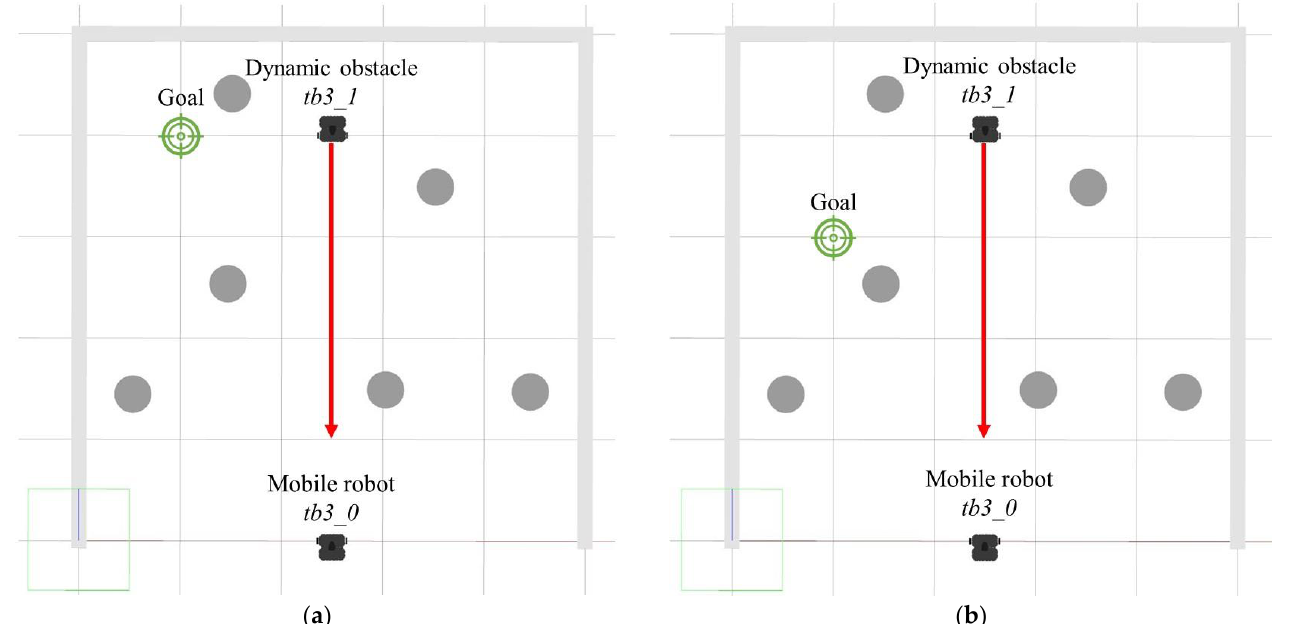
Figure 13. ( a ) Gazebo simulation for dynamic environment scenario 1 with goal point of (1.0,4.0) for 𝑡𝑏3_0 , ( b ) Gazebo simulation for dynamic environment scenario 1 with goal point of (1.0, 3.0) for 𝑡𝑏3_0 .